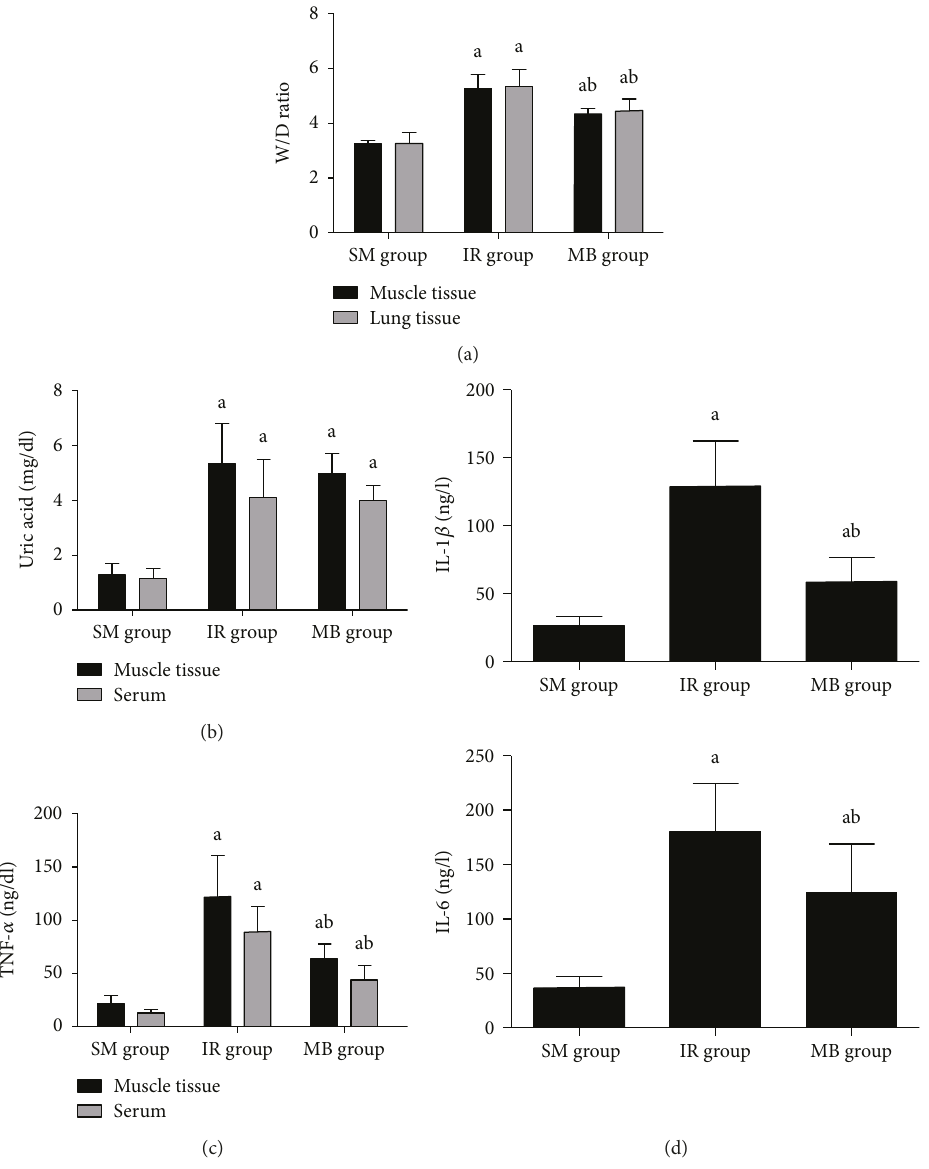
Figure 3: Water content, XO activity, and in fl ammatory cytokines. (a) Water contents in muscle and lung tissues; (b) uric acid levels in muscle and serum; (c) TNF- α level in serum and muscle; (d) IL-1 β and IL-6 levels in BALF. a p < 0 05 versus SM group; b p < 0 05 versus IR group.